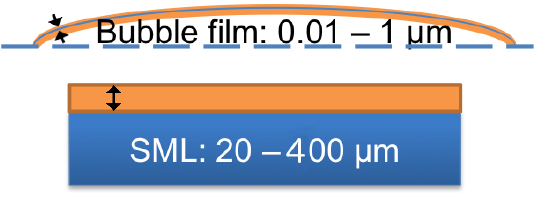
Figure 2. Cartoon of the slab model used for calculation of the en- richment ratio from surface coverage. The bubble film, when resting at the water surface as suggested by the dashed blue line, is partially coated on both sides with organic surface-active materials, while the SML is partially coated on only one side. Bubble film thicknesses range from about 0.01 to 1µm (Modini et al., 2013). SML sampling thicknesses depend upon the sampling method and range from 20 to 400µm (Cunliffe et al.,